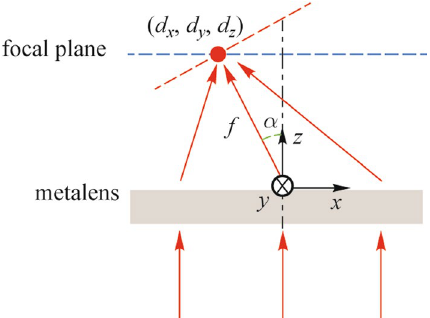
Fig. 3 Schematic illustration of light focusing by the off-axis met- alens. The black dashed line denotes the focal plane, which is perpen- dicular to the z